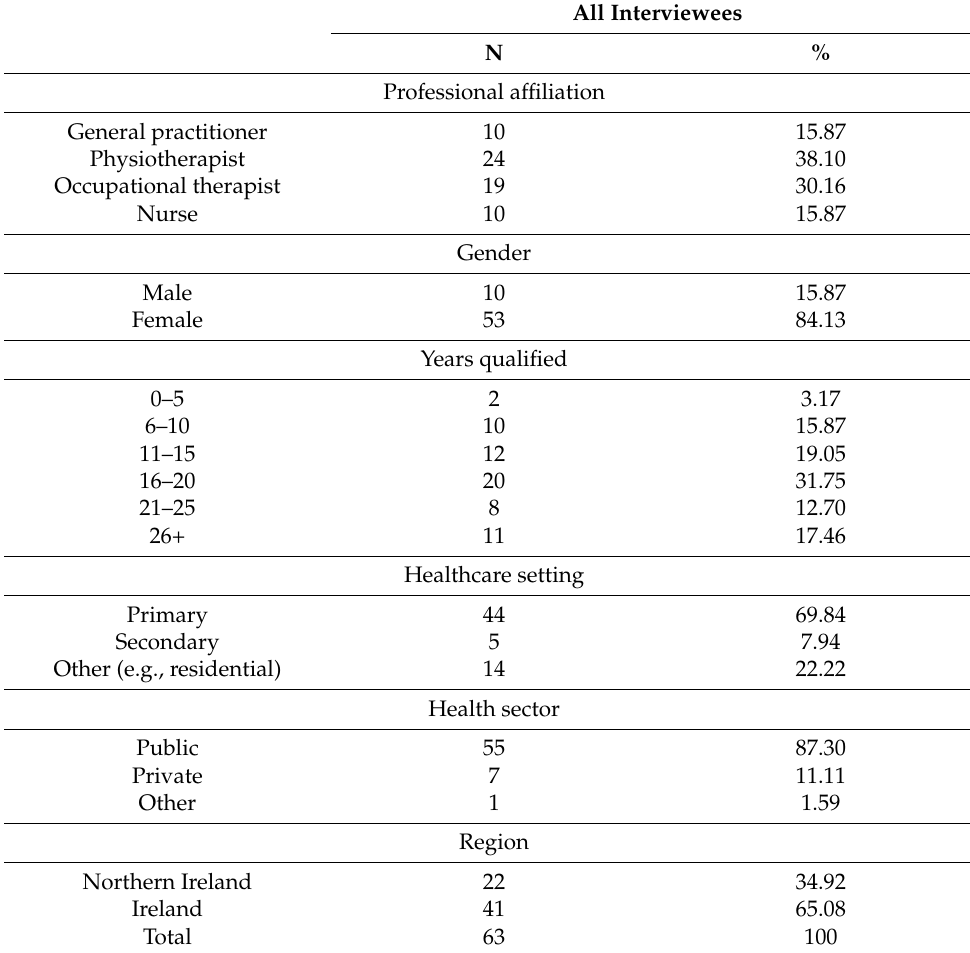
Table 1. Characteristics of interview